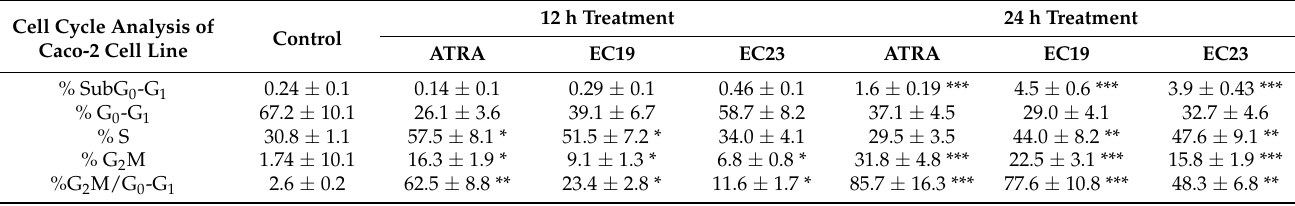
Table 4. Cell cycle analysis of Caco-2 cells after ATRA, EC19 and EC23 treatment for 12 and 24 h showing the DNA content at different cycle phases. % G 2 M/G 0 -G 1 ratio was calculated as the percentage of the dividing cells in the mitotic phase to the growing cells in the G 0 -G 1 phase. Cell Cycle Analysis of Caco-2 Cell